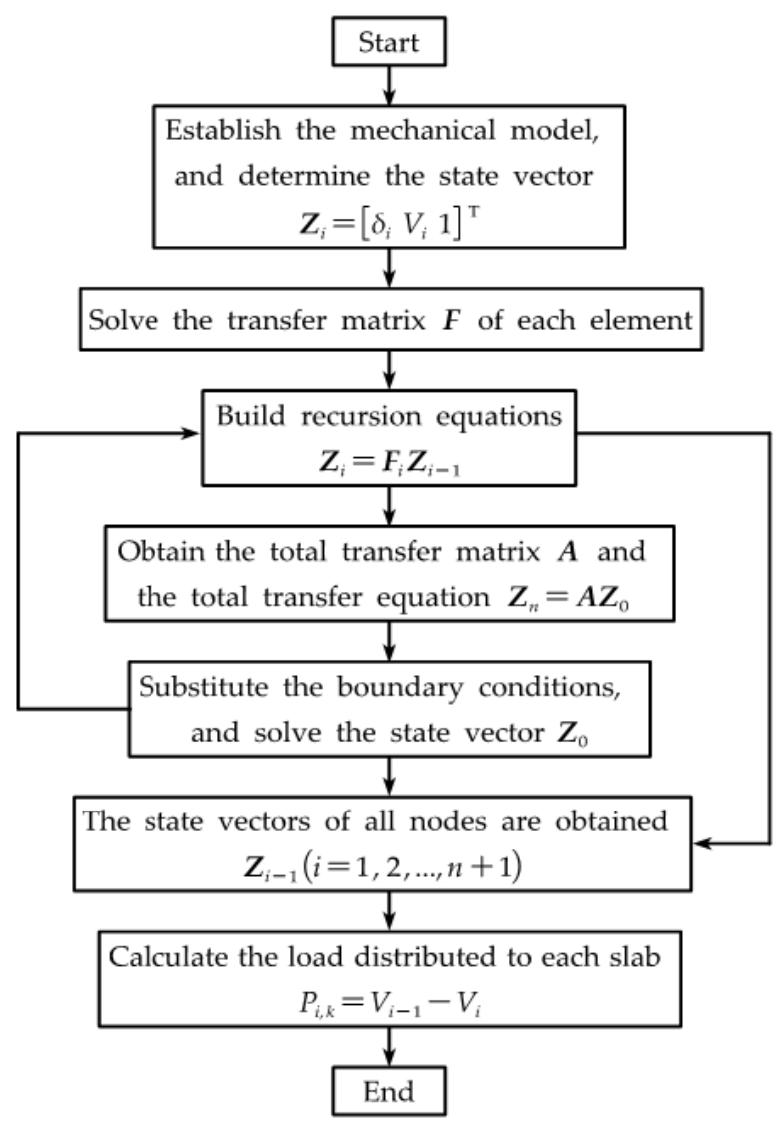
Figure 6. Flowchart of the TLD calculated by TMM.